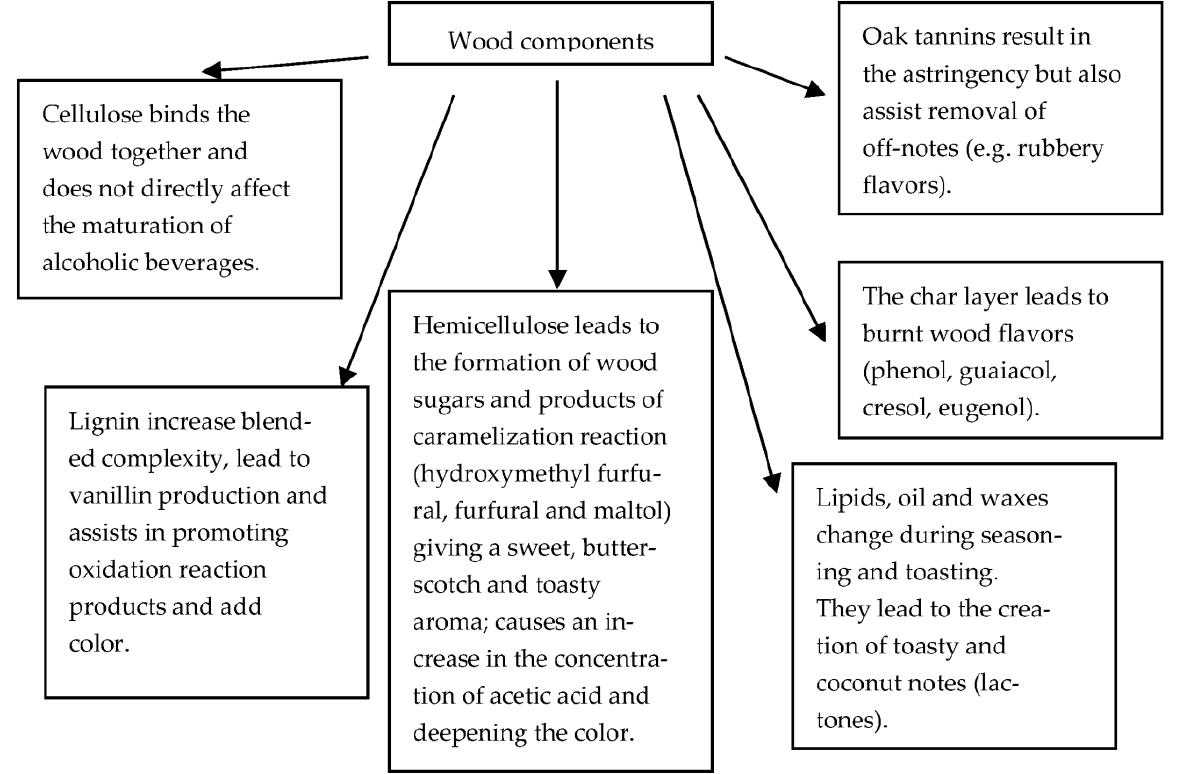
Figure 2. Major wood constituents and basic chemistry [43].